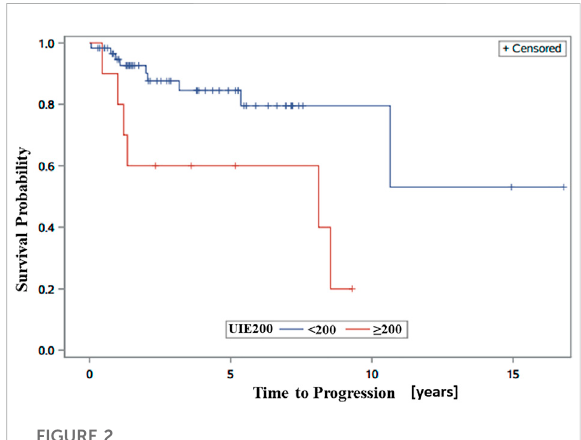
FIGURE 2 Kaplan – Meierprogression-free survival(PFS) curves showing